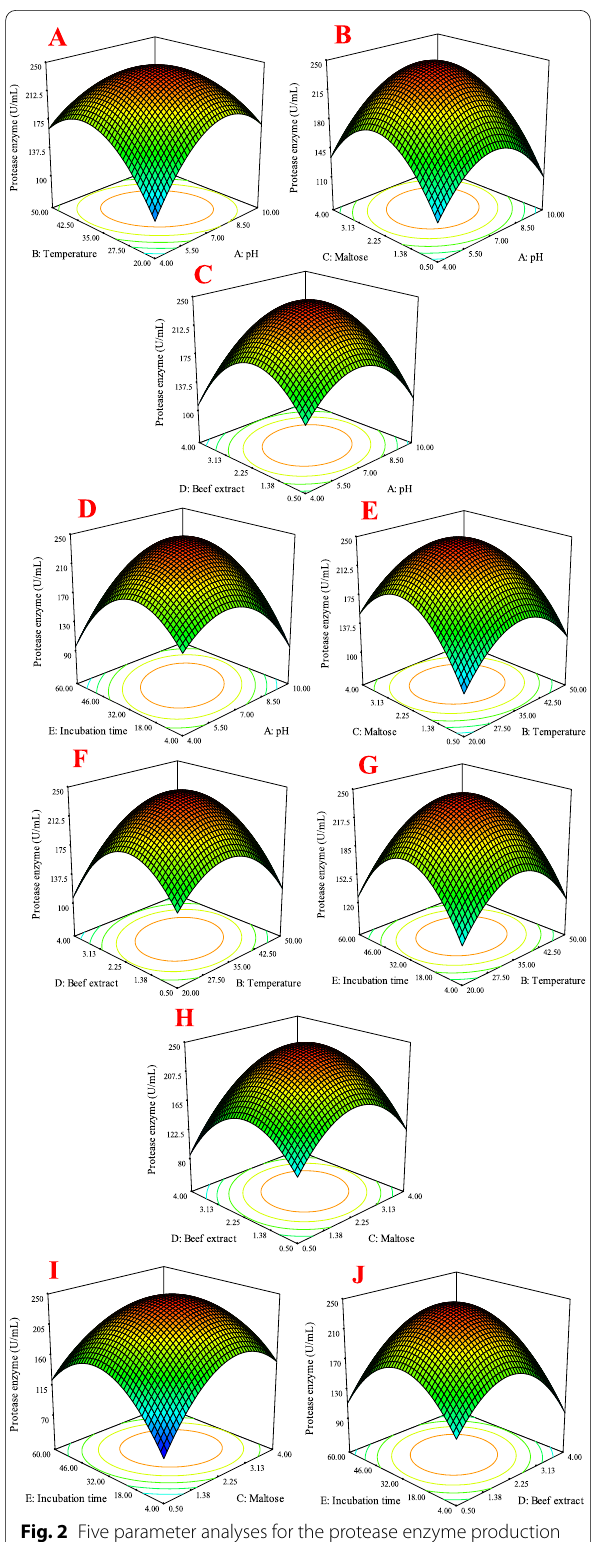
Fig. 2 Five parameter analyses for the protease enzyme production culture condition of Bacillus thuringiensis by